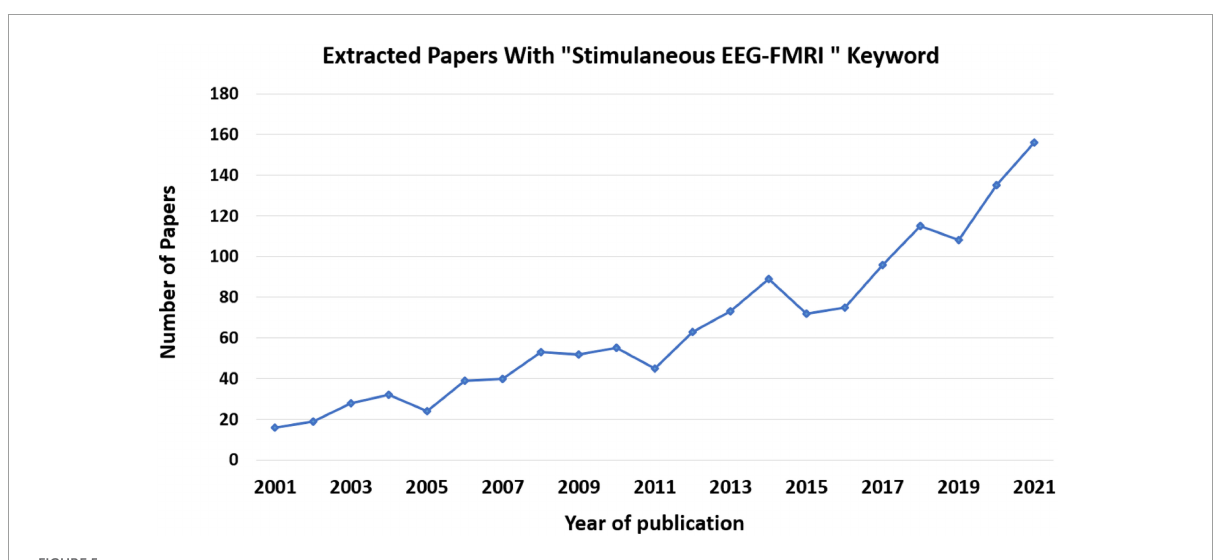
FIGURE5 Number of papers published per year on simultaneous EEG-fMRI. These data came from Pubmed site by searching for “Simultaneous EEG-fMRI” in